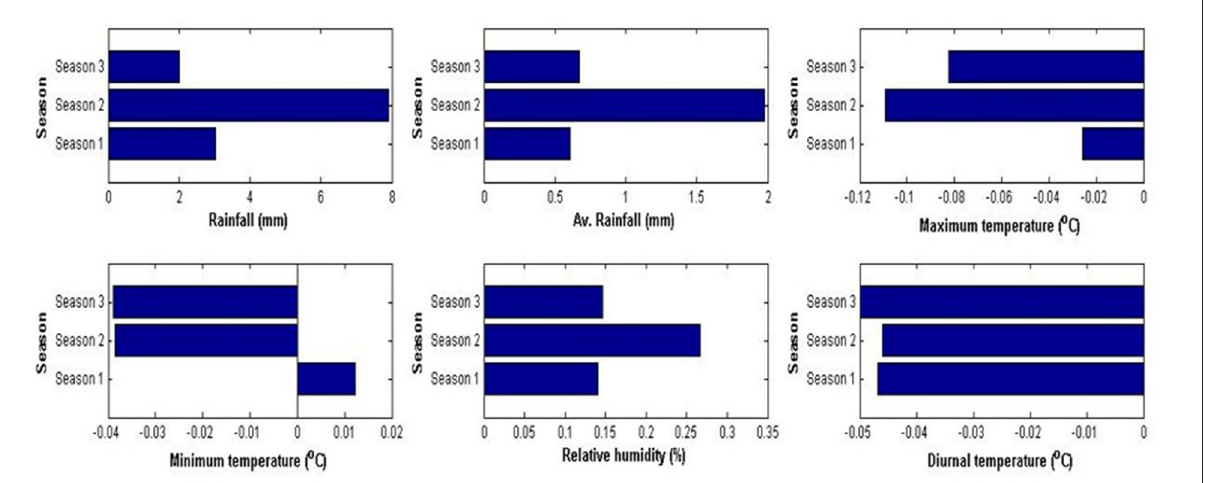
FIGURE1 Sen slopes of trends in climatic variability in temperate UPH, Tamil Nadu.